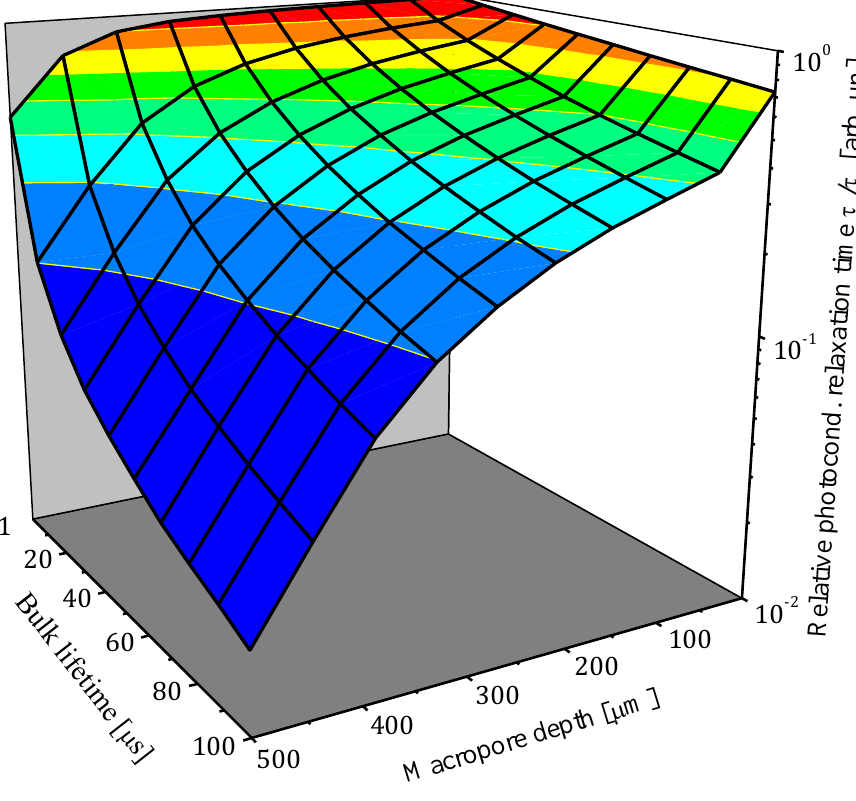
Figure 9. The dependence of the relative relaxation time of photoconductivity on the depth of the macropores and the bulk lifetime at thickness of macroporous silicon is 500